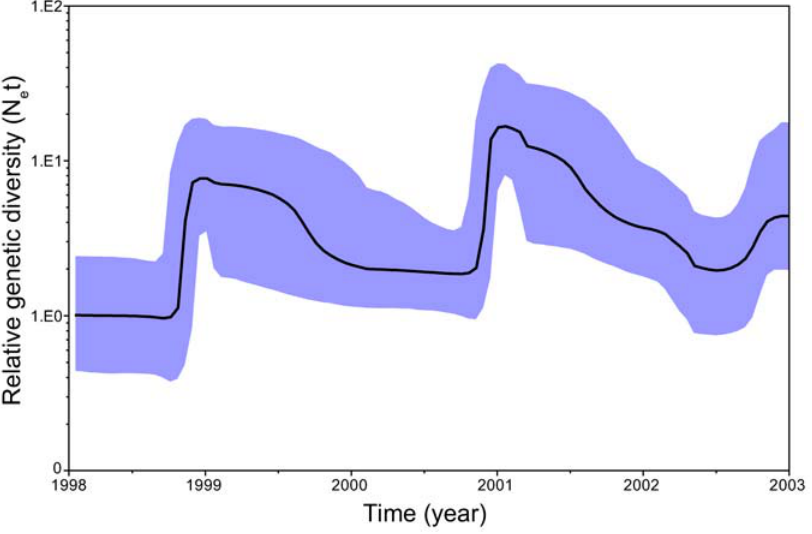
Figure 3. Fluctuating genetic diversity of influenza A virus. The figure shows a Bayesian skyline plot of changing levels of genetic diversity through time for the HA gene (165 sequences) of A/H3N2 virus sampled from the state of New York, US, during the period 2001–2003. The y -axes depict relative genetic diversity ( N e t , where N e is the effective population size, and t the generation time from infected host to infected host), which can be considered a measure of effective population size under strictly neutral evolution. Peaks of genetic diversity, reflecting the seasonal occurrence of influenza, are clearly visible. See [30] for a more detailed analysis.